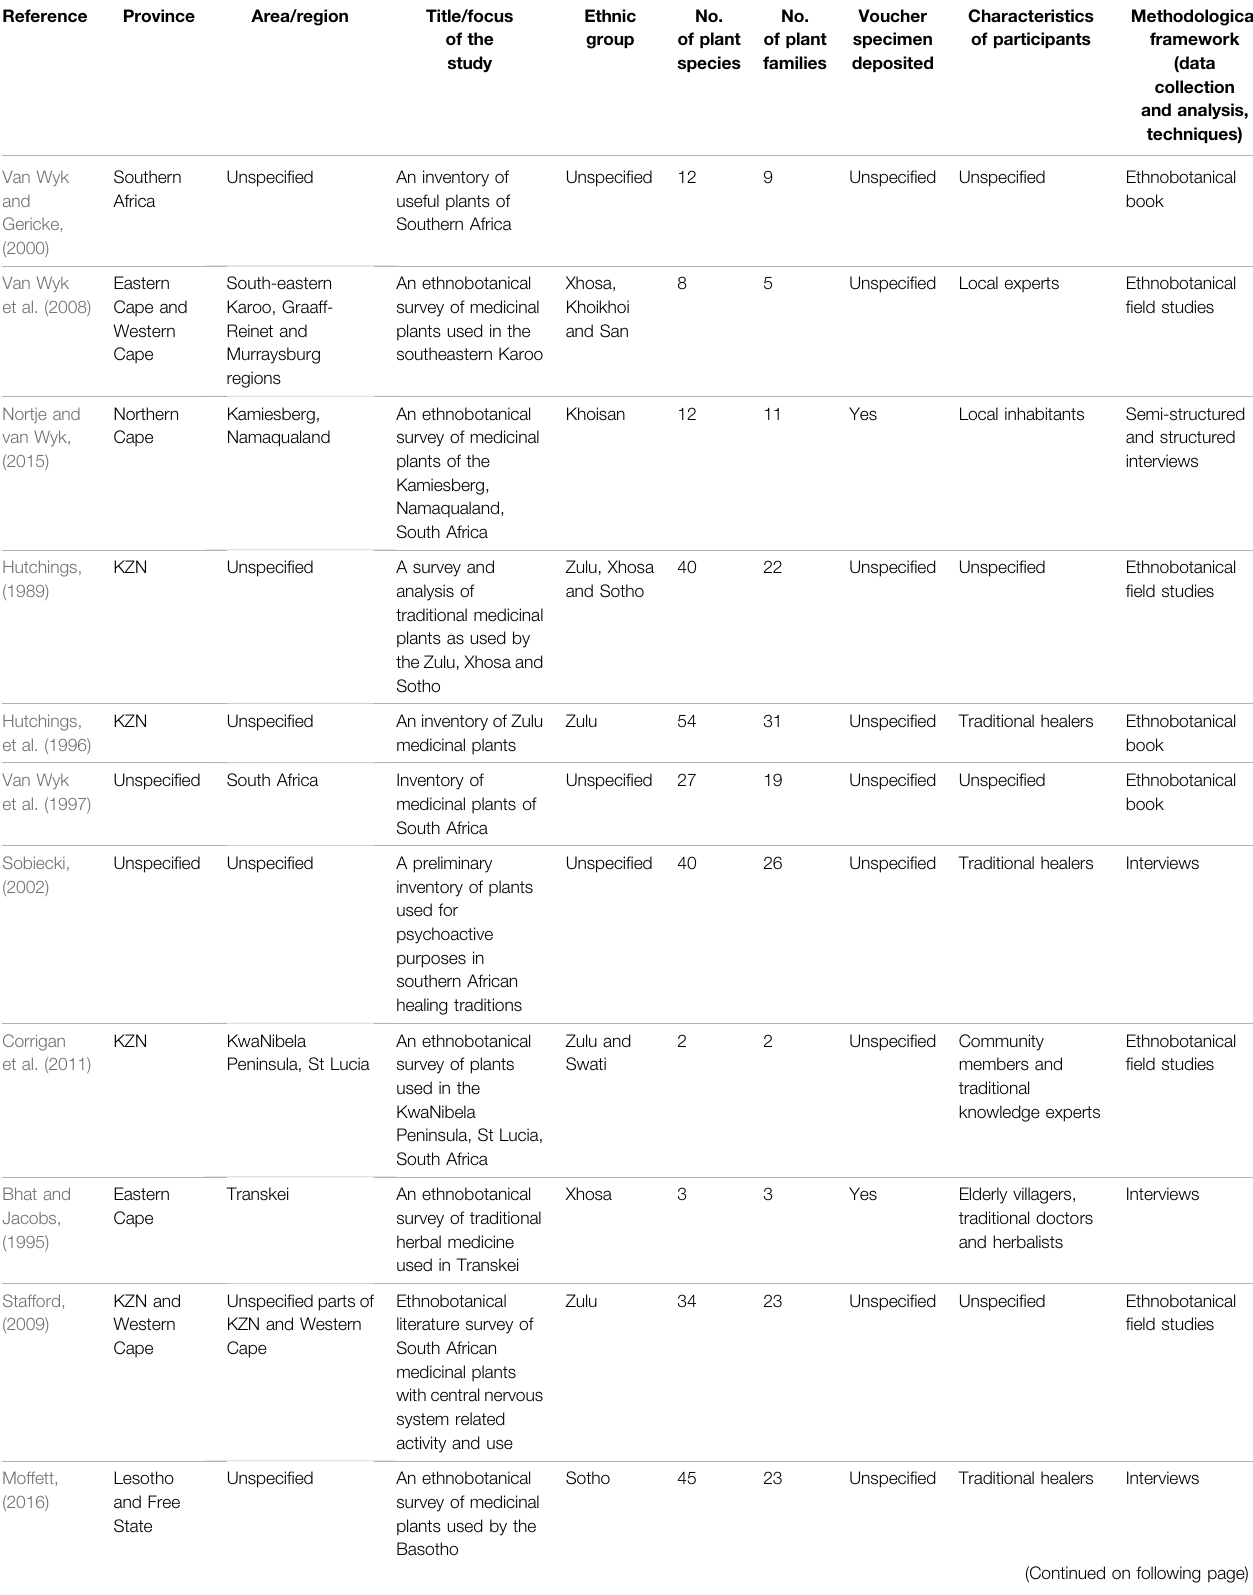
TABLE 1 | An overview of ethnobotanical literature documenting South African medicinal plants with potential antidepressant effects.